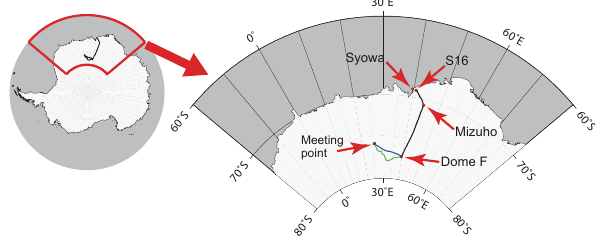
Figure 1. Traverse routes of Japanese team during JASE campaign. Black lines represent traverse routes between S16 and Dome F in in- coming and outgoing traverse. The blue line represents the traverse route from Dome F to meeting point in the incoming traverse. The red line represents traverse route from the meeting point to Dome F in outgoing traverse. The traverse route of the Swedish team was depicted in Fujita et al.